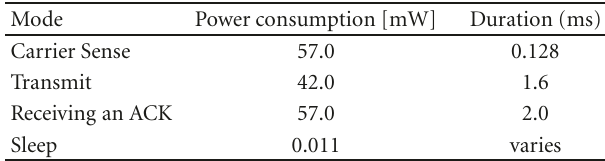
Table 1: Power and time constraints when the tag is in di ff erent